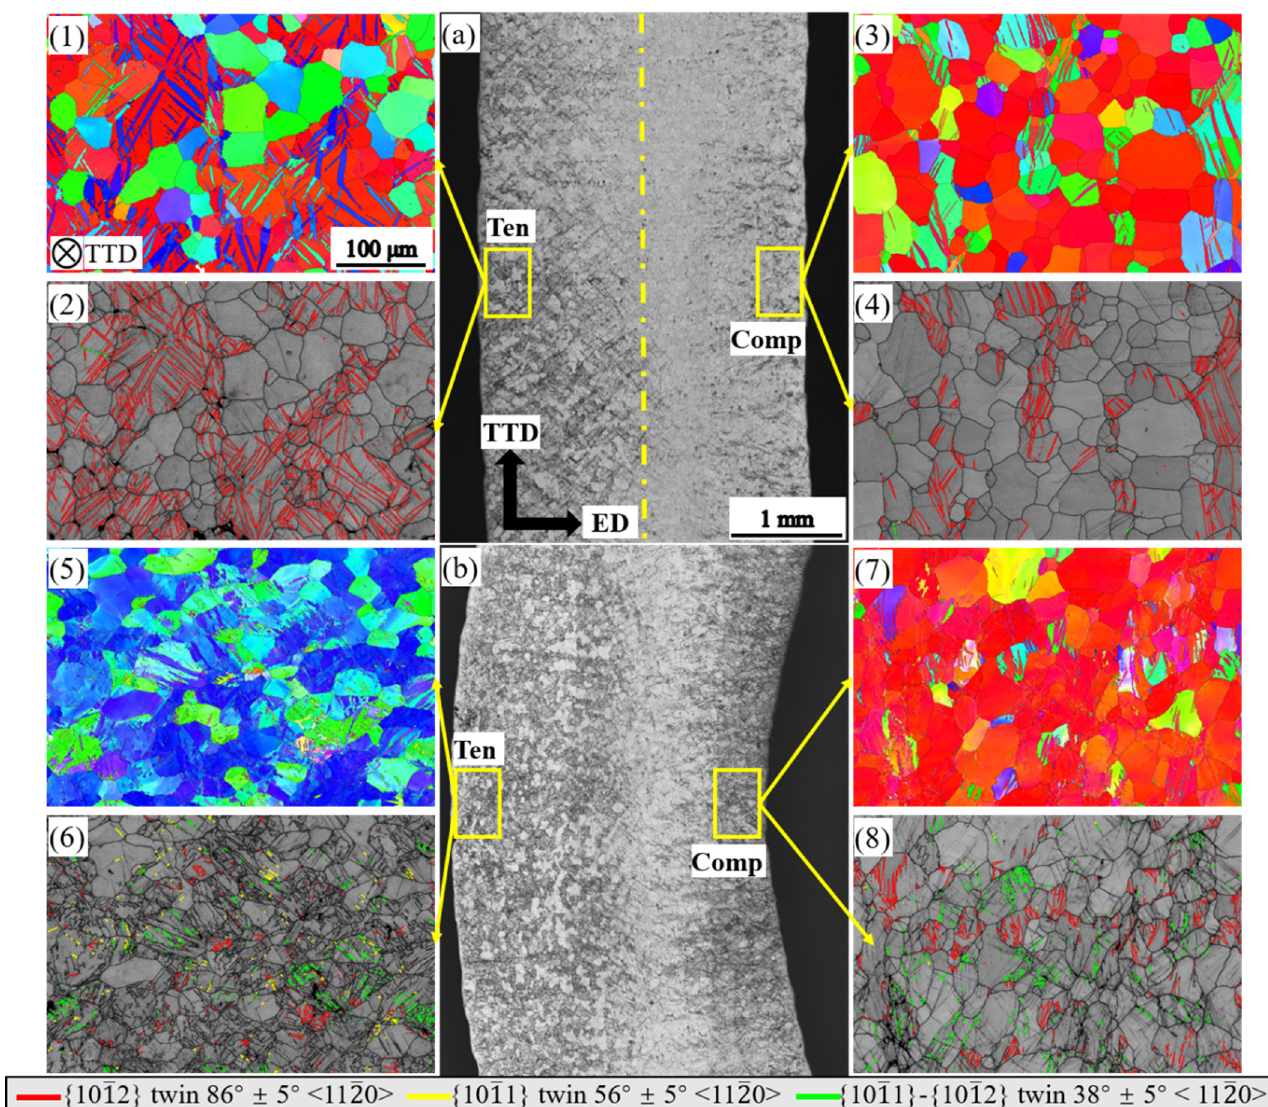
Figure 6. Microstructure of the TTD bending bar at a bending displacement of 3 mm and at fracture: ( a , b ) optical micrograph of the bent sample; ( 1 , 3 , 5 , 7 ) inverse pole figures of the bent bar; ( 2 , 4 , 6 , 8 ) band contrast map of the bent bar with twinning boundary characterized.